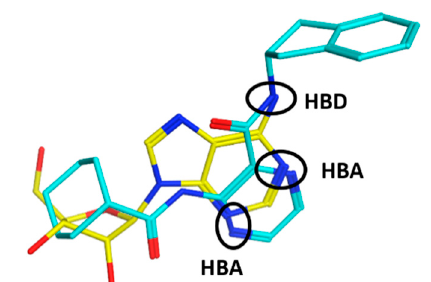
Figure 1. Overlay of the referenced Adachi ligand (pdb id: 5VAD) with blue carbons and adenosine (pdb id: 2J3L) with yellow carbons.